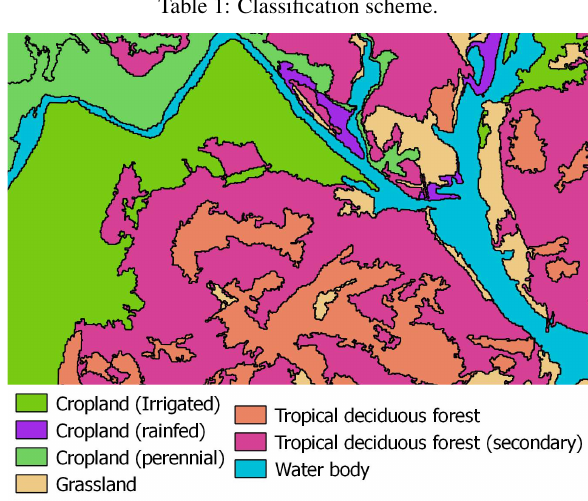
Figure 3: 2003 LUC map.